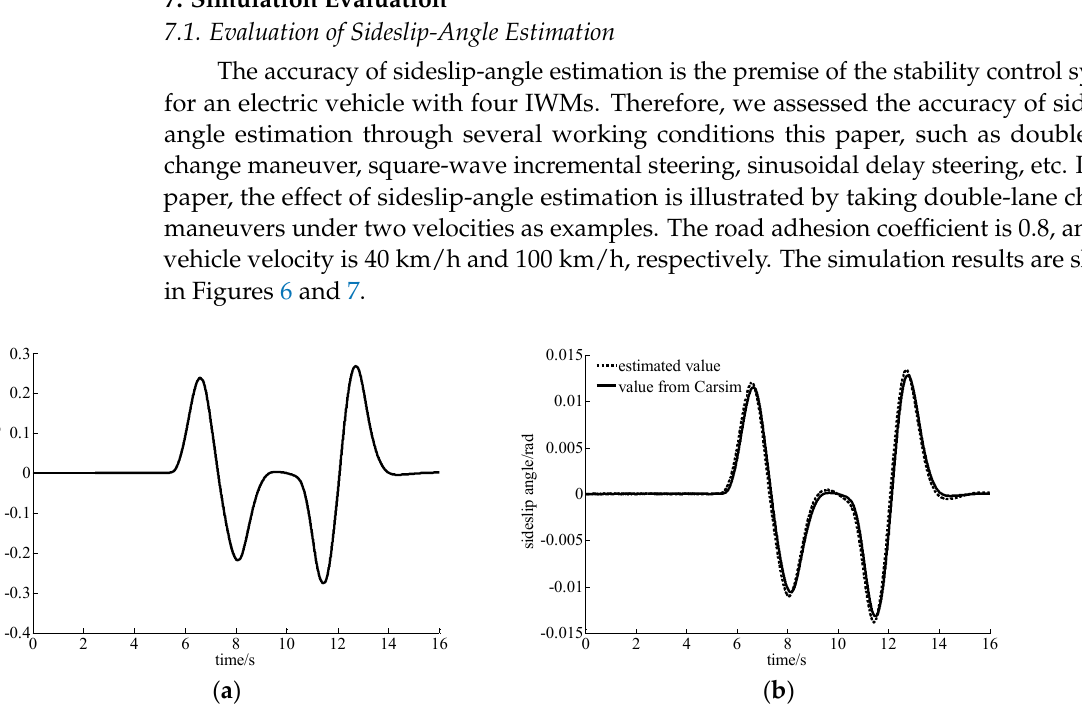
( b ) Figure 7. Estimation for sideslip angle (when V x is 100 km/h and μ is 0.8) ( a ) Lateral acceleration. ( b ) Sideslip angle. It can be known from Figure 7 that the lateral acceleration of the vehicle is more than 0.4 g when the vehicle velocity is 100 km/h, indicating that the vehicle is in an unstable state. The estimation of sideslip angle by the extended Kalman filter algorithm is slightly less than the output value of Carsim at the peak value, and other parts can follow the output value of Carsim well. The simulation results show that the proposed estimation algorithm for sideslip an- gle can follow the output value of Carsim, no matter if the vehicle is stable or unstable, and can meet the requirements of stability control system of electric vehicle with four IWMs.